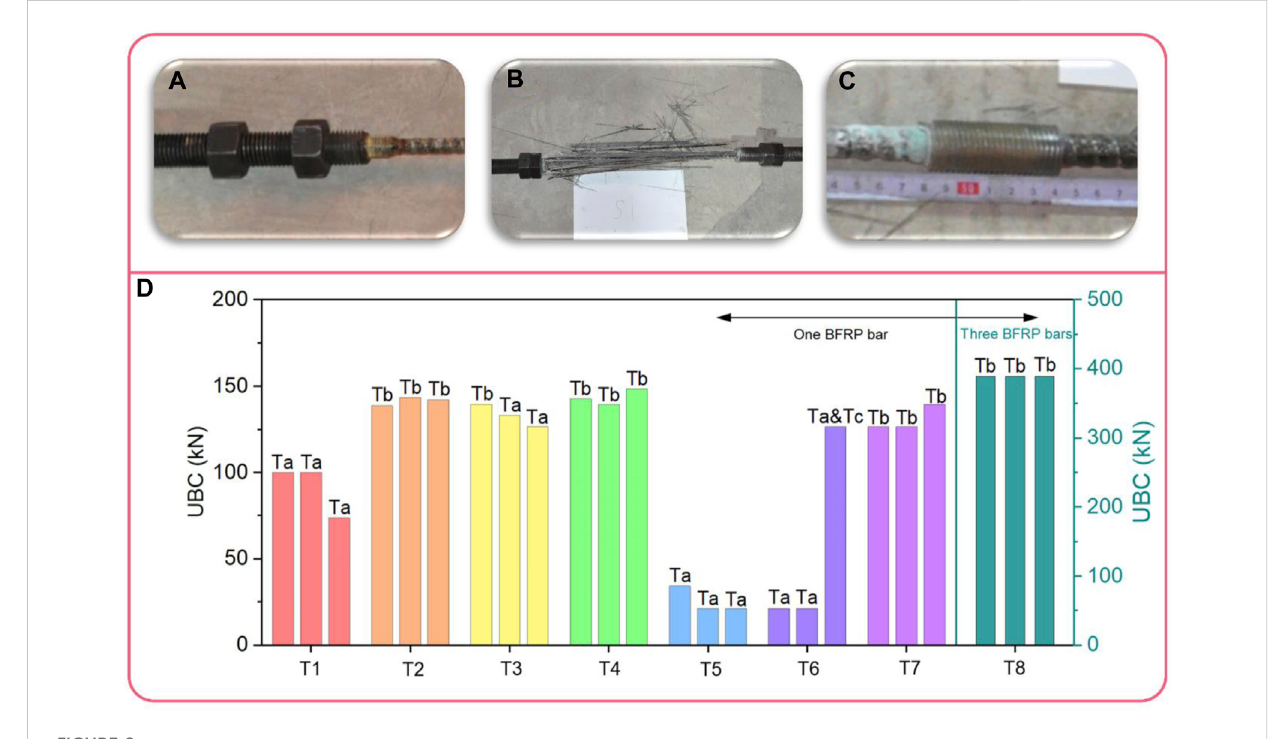
FIGURE 8 Failure modes and UBC testresults of theTSAS: (A) Slip failure of the interface (Ta), (B) BFRP bar bursting (Tb), (C) Fracture of the threaded steel pipe (Tc), (D) UBC test results of the TSAS.